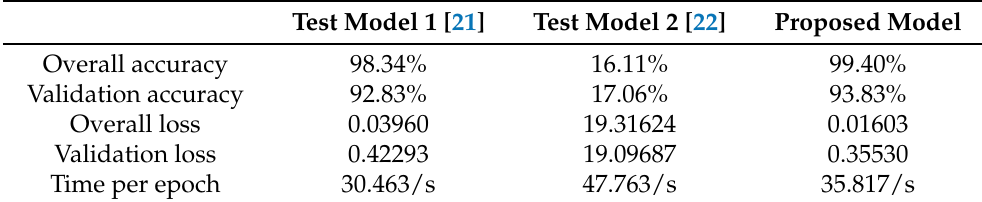
Table 18. Second observation after 100 epochs of training of experiment 2.